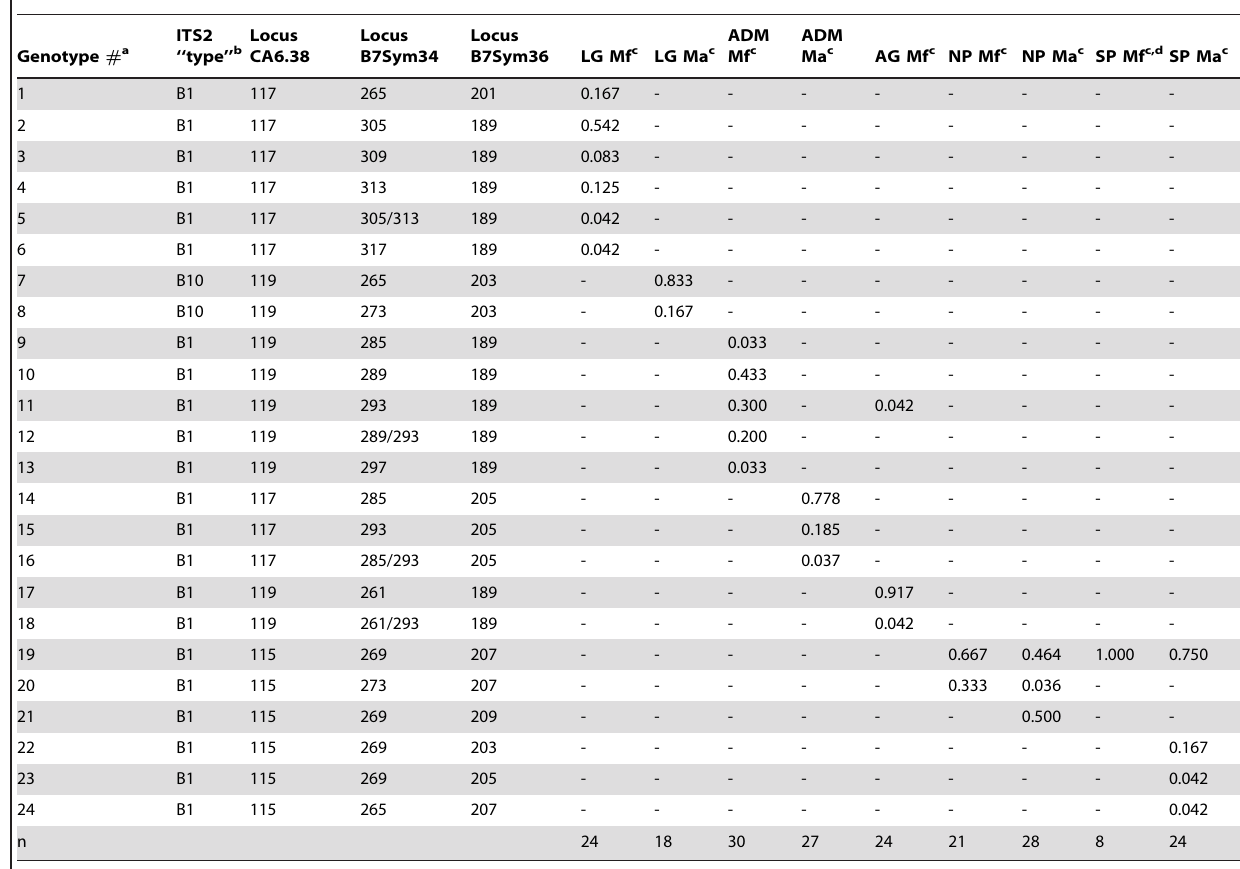
Table 4. Relative frequencies and distributions of Symbiodinium Clade B ITS2 ‘‘types’’ and multilocus microsatellite genotypes in tagged colonies of M. faveolata and M. annularis collected between 2003 and 2005 in the Upper Florida Keys (U.S.) and Exuma Cays